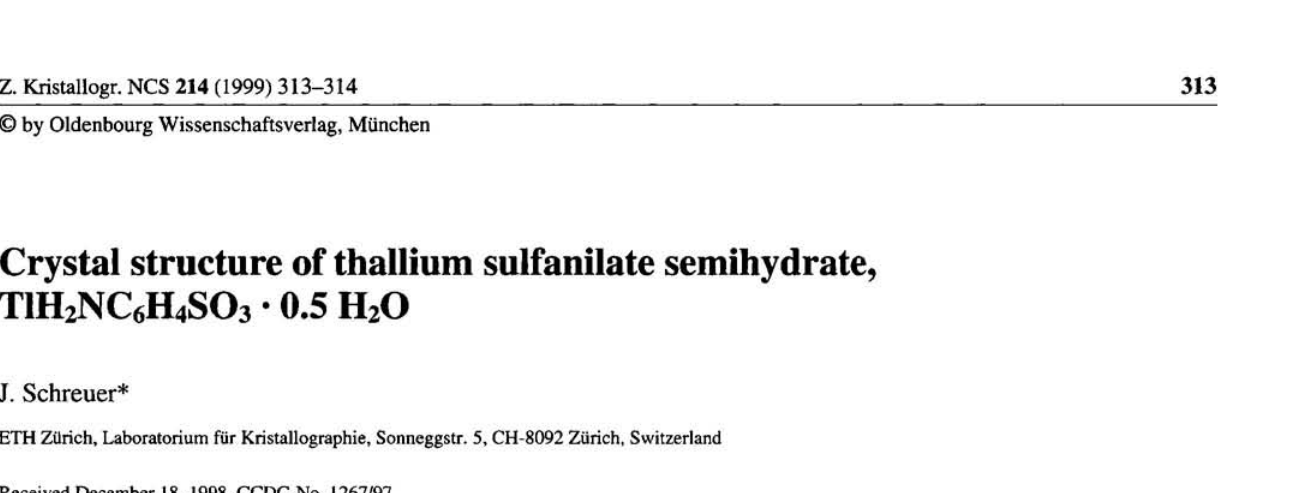
Table 1. Data collection and handling.